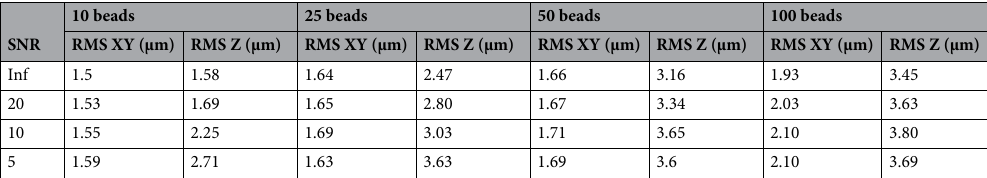
Table 1. RMS error of microbead localization for varying SNR and number of microbeads (5 μm diameter; volume is set to yield high concentration of 2270 beads/mm 3 and strong shadow density 44 equal to 5675 for 10 beads case). RMS XY was calculated as: RMS